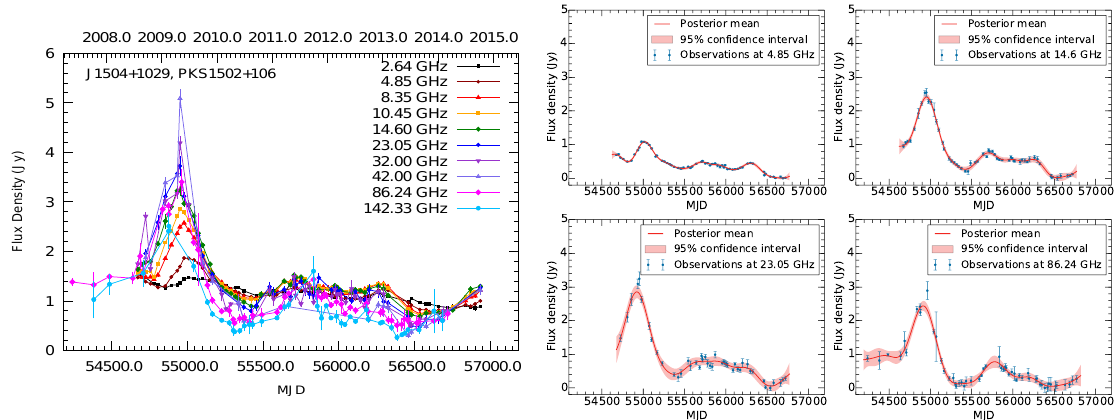
Figure 2. Multi-wavelength light curves of PKS1502+106. ( Left ) F-GAMMA light curves between 2.64 and 142.33GHz; ( Right ) GP regression curves for the data at 4.85, 14.6, 23.05, and 86.24GHz. For the results at all frequencies, see Ref.